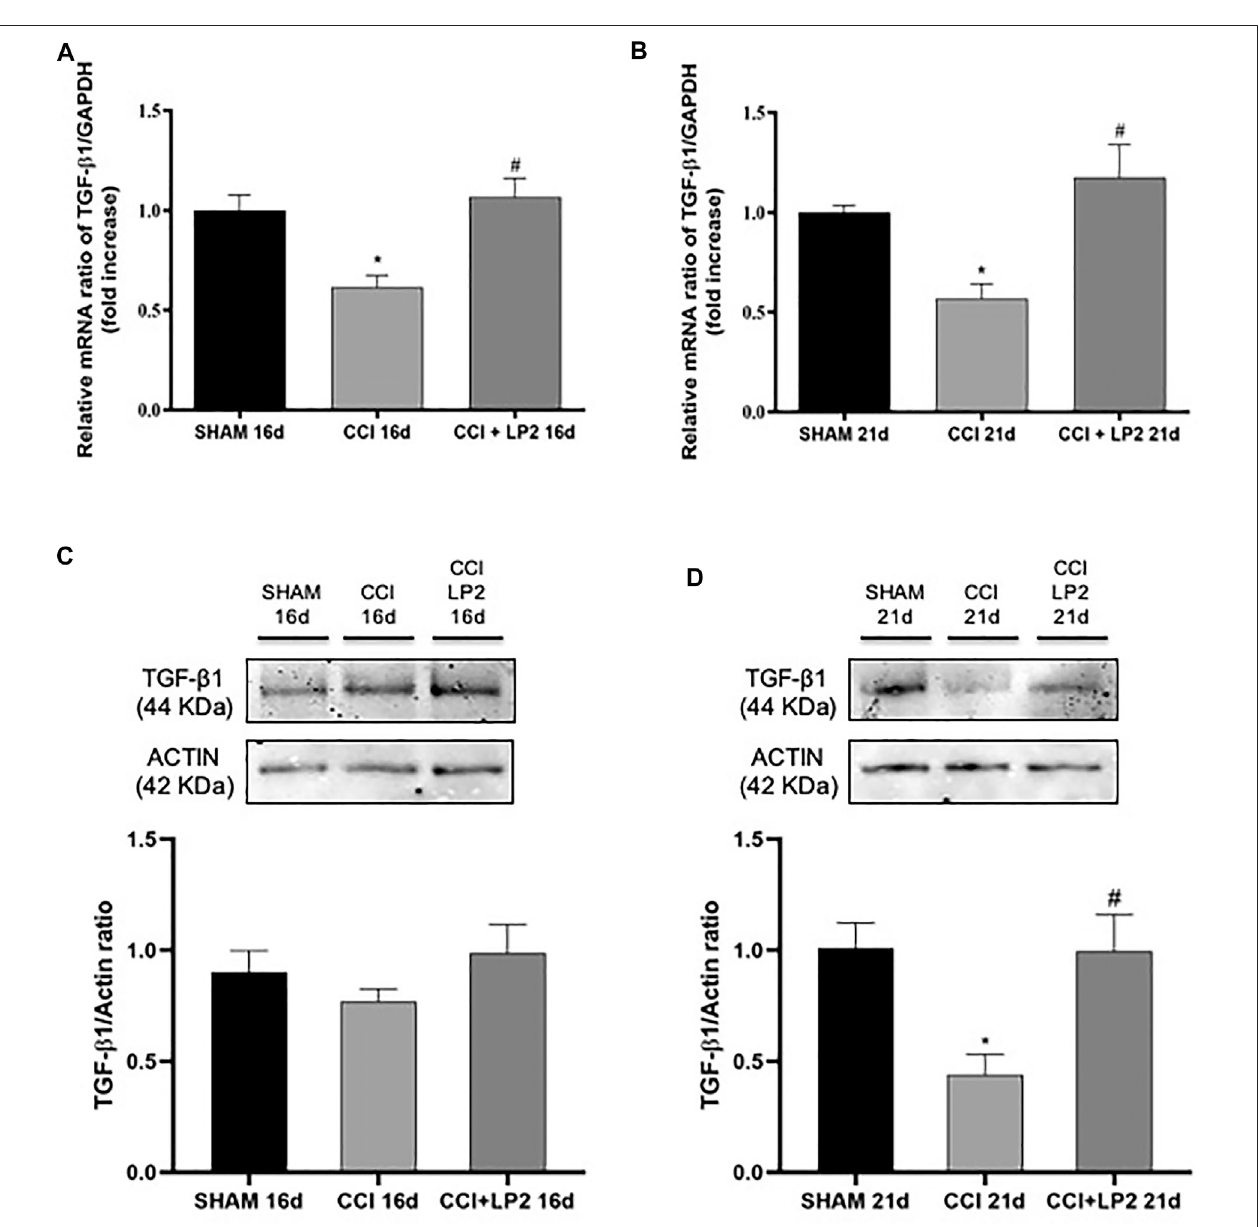
FIGURE3| LP2treatmentrescuesTGF- β 1levelsat 16and21 daysafterchronicconstriction injury.Measurementof (A – C) TGF- β 1at16 days and (B – D) TGF- β 1 at21 daysmRNAandproteinexpressionlevelsinspinalcordofSHAM,CCI,andCCI+LP2rats. (A – B) TheabundanceofeachmRNAofinterestwasexpressedrelative totheabundanceofGAPDHmRNA,asaninternalcontrol.Dataareshownasmean ± SEMof n (cid:1) 3ratspergroup.TGF- β 116 days[F(2,6) (cid:1) 10,02];TGF- β 121 days[F (2, 7) (cid:1) 9,961]. (C – D) Representative immunoblots of TGF- β 1 (44 kDa) in total protein extracts from spinal cord tissues at 16 (F (2, 15) (cid:1) 1,222) and 21 [F (2, 9) (cid:1) 6,638] dpl. Histograms refer to independent experiments means ± SEM of the TGF- β 1 densitometric values normalized against actin used as internal control. Data are shown as mean ± SEM of n (cid:1) 4 – 6 rats per group. Statistical analysis was performed using one-way ANOVA with Bonferroni ’ s post-hoc analysis. * p < 0.05 vs. SHAM; # p < 0.05 vs.